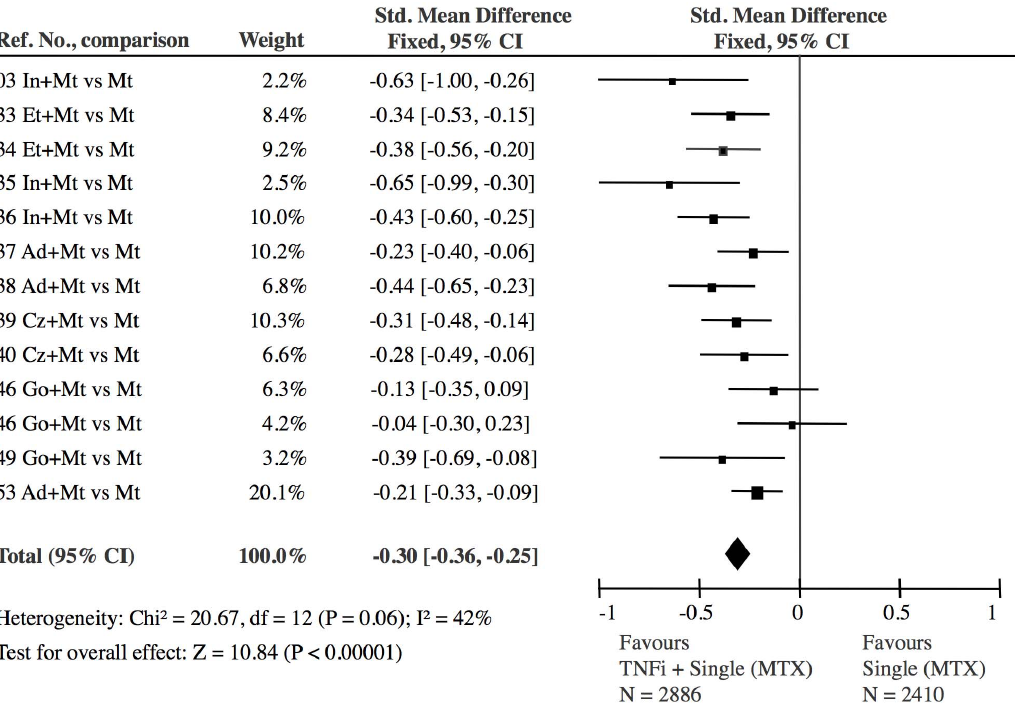
Figure 6. TNF inhibitor combined with methotrexate versus single DMARD (methotrexate): The effect of TNF inhibitor was highly significant (Z=10.84). The 13 TNF inhibitor studies showed no significant heterogeneity (I 2 =42%, p=0.06). The borderline heterogeneity was due to two golimumab studies (GoBefore, GoForward) [46]. The exclusion of these, did, however, not change the overall result ( 2 0.33 SMD (CI: 2 0.39, 2 0.27)).